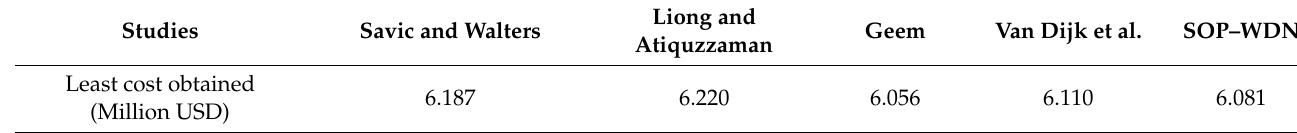
Table 9. Comparison of SOP–WDN results to past studies for the Hanoi network.